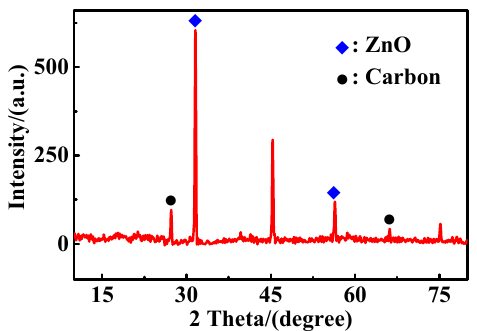
Figure 1. The XRD pattern of the zinc oxide-loaded lignin-based carbon fiber (ZCF).